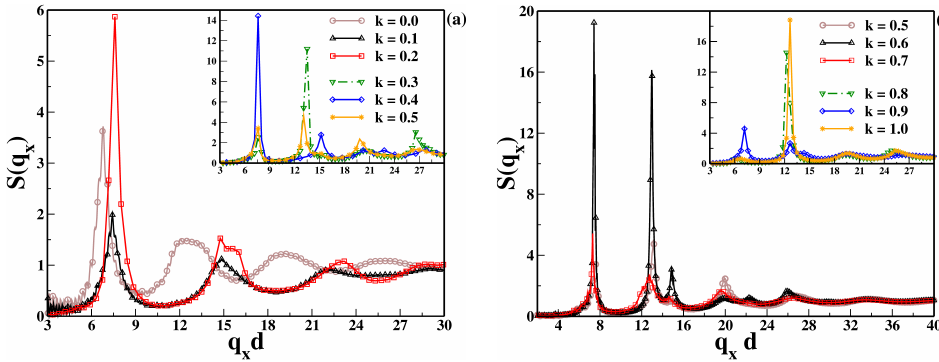
Figure 5. Static structure factor along the x -direction for several values of the stiffness parameter: ( a ) 0 ≤ k ≤ 0.5 and ( b ) 0.5 ≤ k ≤